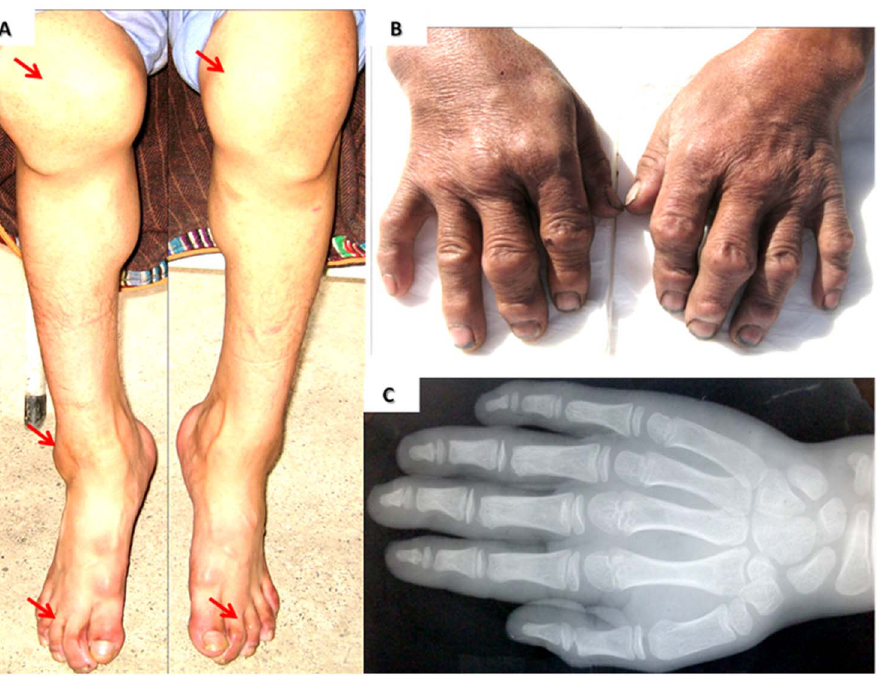
Figure 1. Clinical features of KBD patients. A. A female KBD patient with her knee, ankle and toe joints deformity, the arrows show multiple joints of this patient are affected. B. A male KBD patient with his fingers joints deformity. C. The X-ray picture of a KBD patient’s hand.